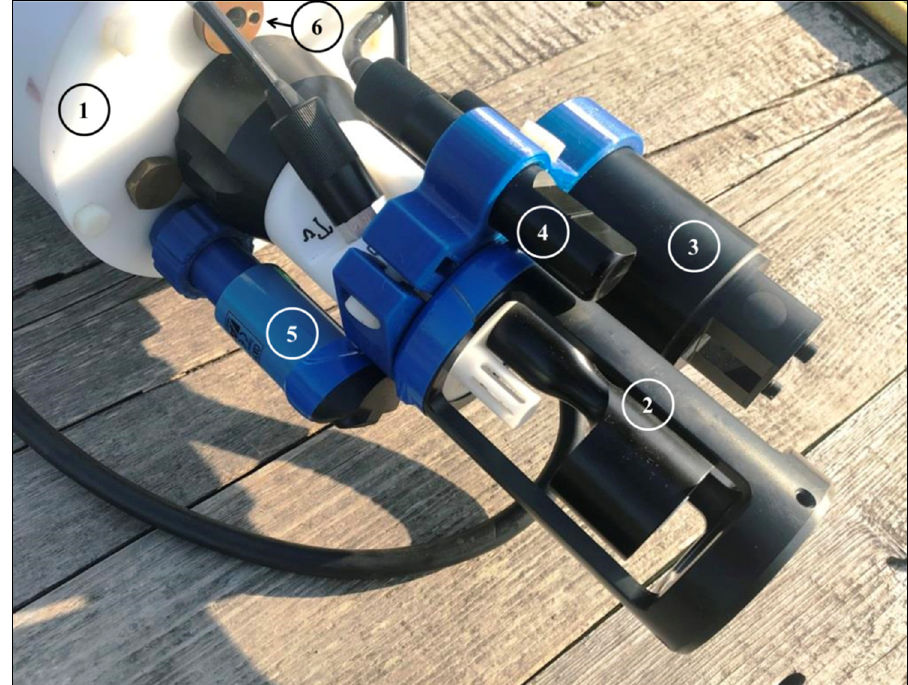
Figure 8. Sensor suite of Winchi: (1)—pressure-proof housing with end cap, (2)—CTD probe of logger RBRconcerto C.T.D++, (3)—Seapoint Chlorophyll Fluorometer (SCF), (4)—Seapoint Turbidity Meter, (5)— Aanderaa 4831F dissolved oxygen sensor, and (6)—pressure sensor (this port can be used for a custom sensor). It is assumed that this backbone of core biogeochemical and physical measurement instruments will be supplemented by pH, CO 2 , and CH 4 sensors in the future.